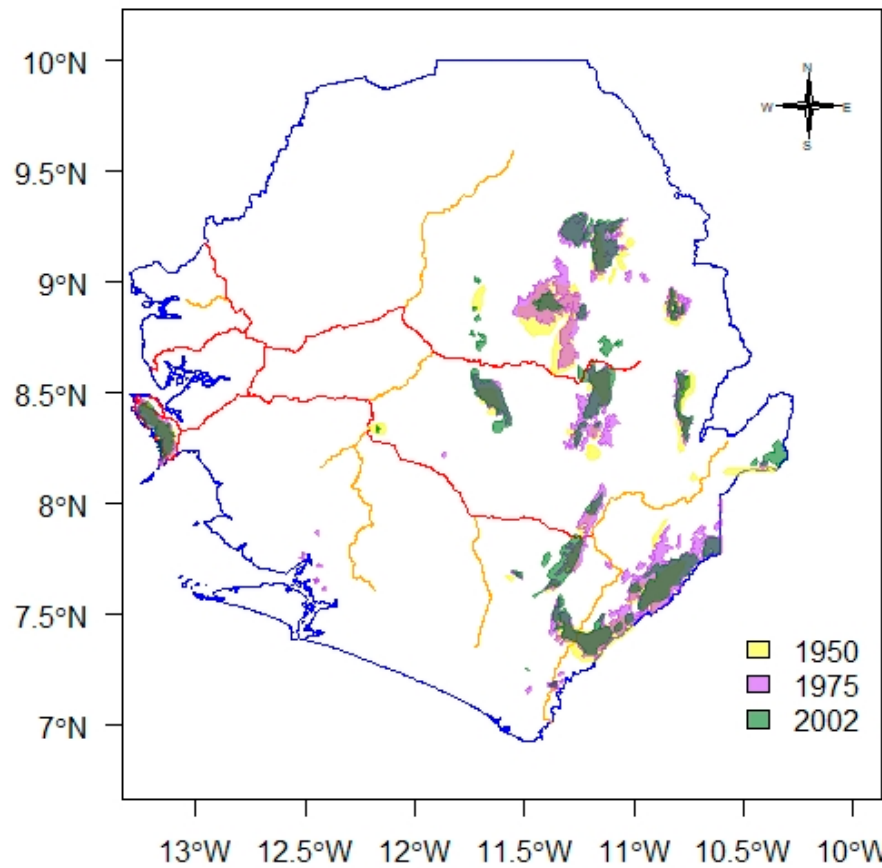
Figure 3. Major forested areas in Sierra Leone, 1950, 1975, and 2002. (Major roads indicated in red (tarred) and orange (gravel)).